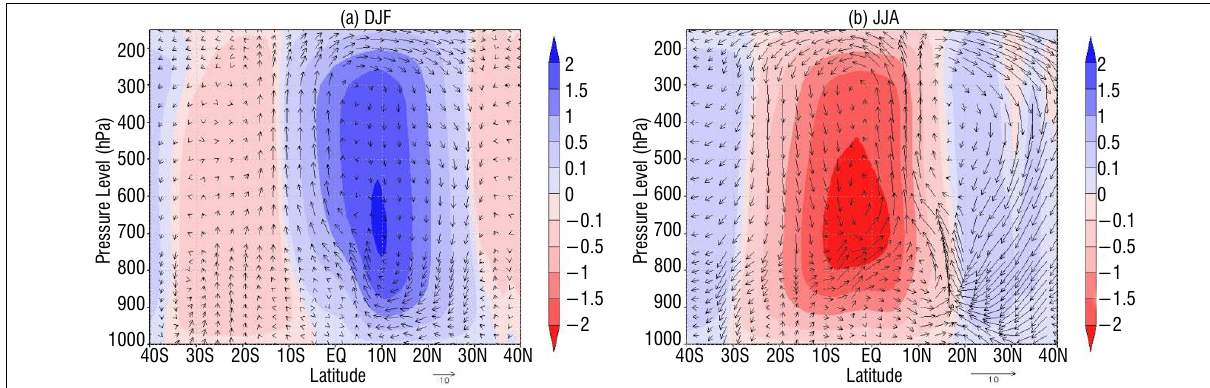
Figure 1: Climatology of zonally averaged stream function with clockwise direction (red shades) and anticlockwise direction (blue shades) and divergent circulation on a meridional plane (wind vectors) for (a) December–February (DJF) and (b) June–August (JJA). The contour intervals for the stream function are 10 11